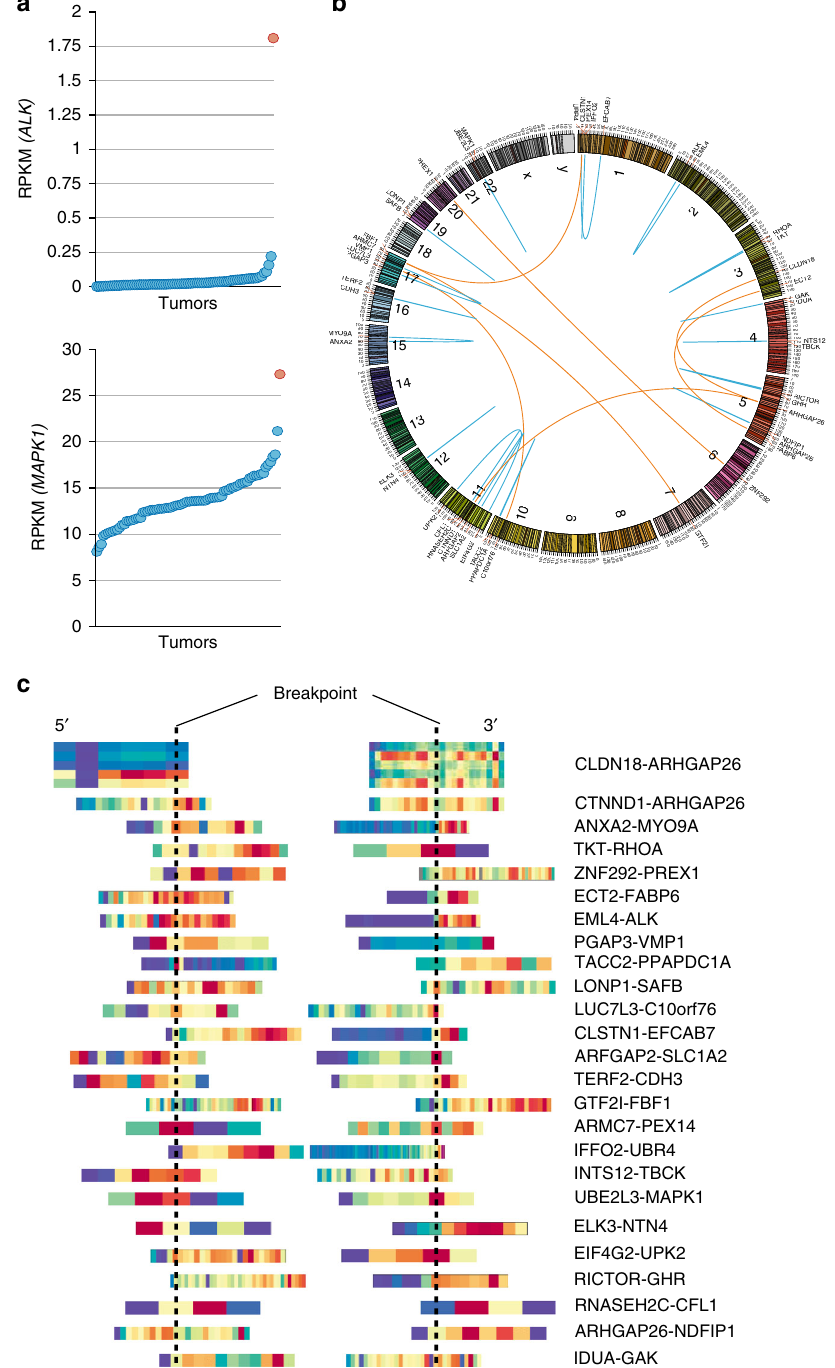
Fig. 1 Twenty- fi ve in-frame gene fusions identi fi ed in a discovery dataset of 80 early-onset DGCs ( a ) Top panel, Expression level of ALK in the tumor containing the EML4-ALK fusion (magenta circle). Each circle represents each tumor. Sample ordering according to ALK expression level. Bottom panel, Expression level of MAPK1 in the tumor containing the UBE2L3-MAPK1 fusion (magenta circle). Sample ordering according to MAPK1 expression level. ( b ) Circos plot for the 25 in-frame fusions. ( c ) Exon-level, Fragments Per Kilobase Of Exon Per Million Fragments Mapped (FPKM) values for the in-frame gene fusions. Heatmap after gene centering. Dotted lines, mRNA breakpoints; Red, higher expression level; Blue, lower expression level. In a majority of fusions, 3 ’ partner genes overexpressed exons that were located 3 ’ to the